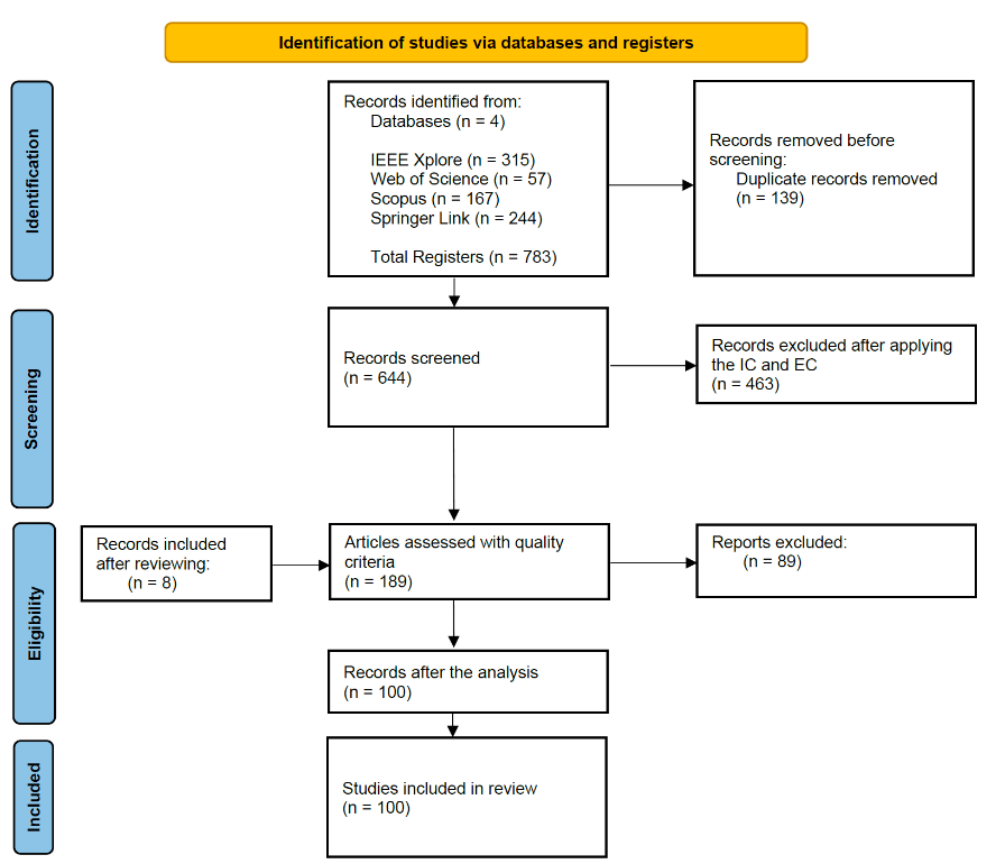
Figure 1. Review process using the PRISMA 2020 flow diagram.